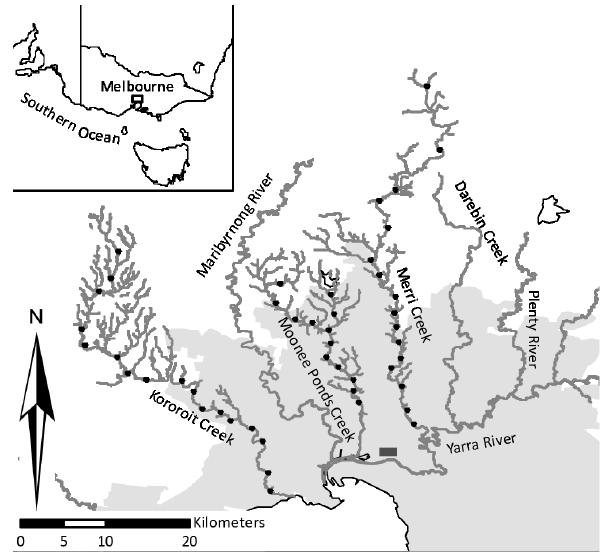
Figure 1. Map of the study area. Circles indicate the location of survey transects. The grey area represents the extent of current development, with the dark grey rectangle indicating the central business district of the city. Waterways in